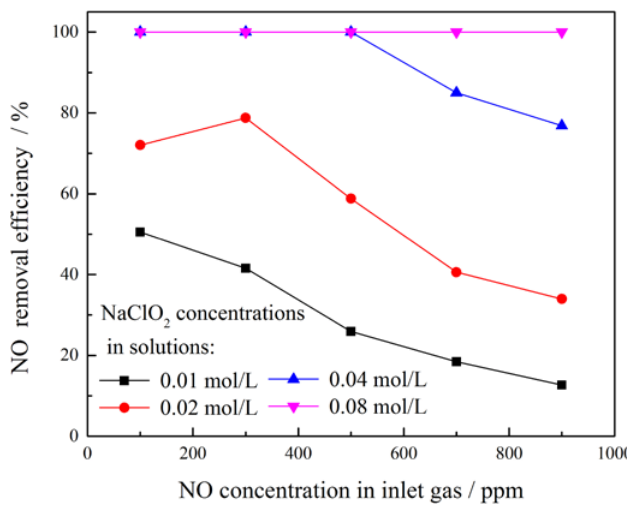
Figure 7. The change of the NO removal efficiency with the NO concentration of the inlet gas.